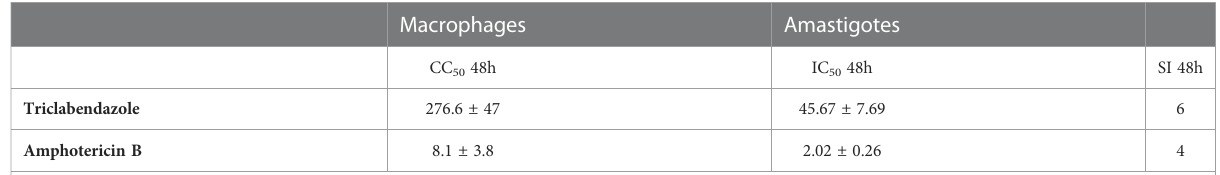
CC 50 and IC 50 are shown in m M. Standard deviation is shown by